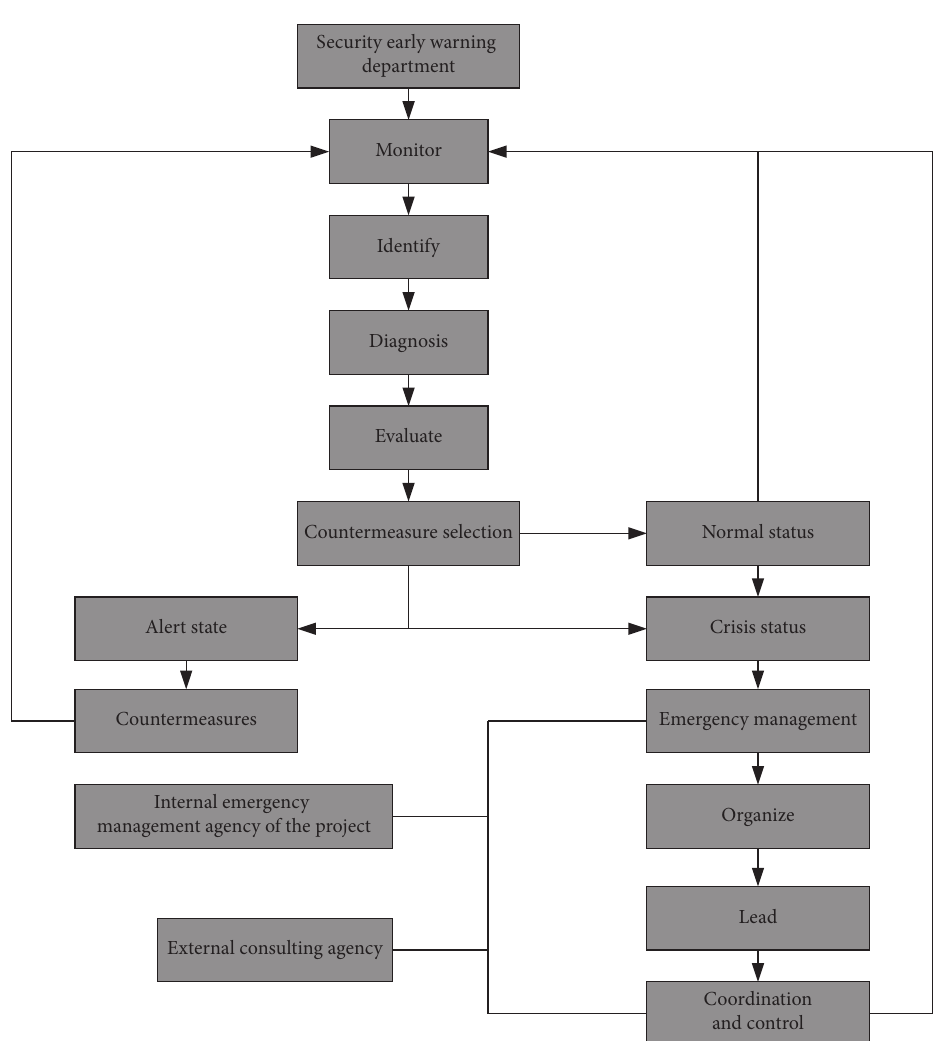
Figure 4: Work safety early warning system